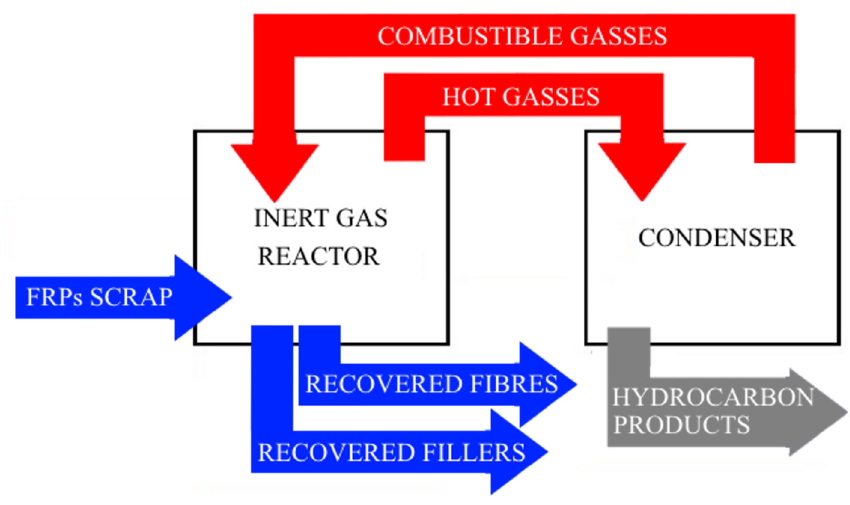
Figure 7. Schematisation of a typical pyrolysis process for thermoset composite materials.